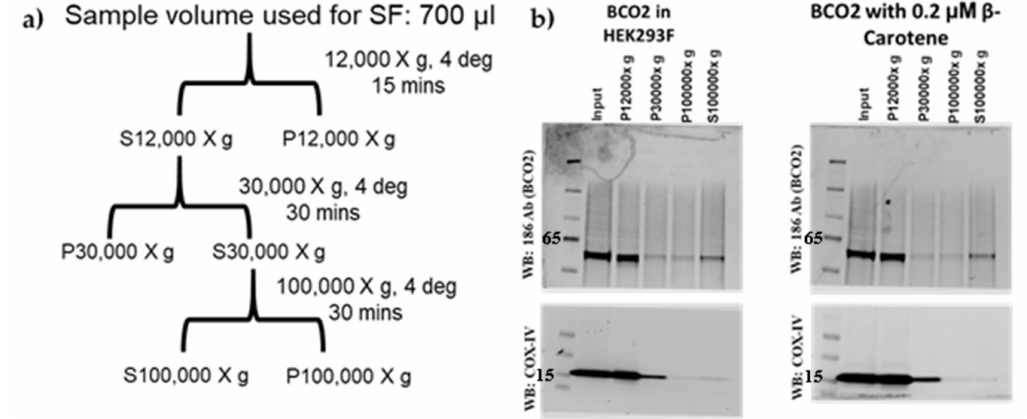
Figure 4. Sucrose Sub-cellular Fractionation 293F-overexpressed mBCO2. ( a ) Scheme of subcellular fractionation; ( b ) Immunoblotting of subcellular fractions of HEK293F cells transfected with mBCO2 with (right two panels) or without β -carotene (left two panels) with 186 (anti-BCO2) antibody (top panel) and mitochondrial marker COXIV antibody (bottom